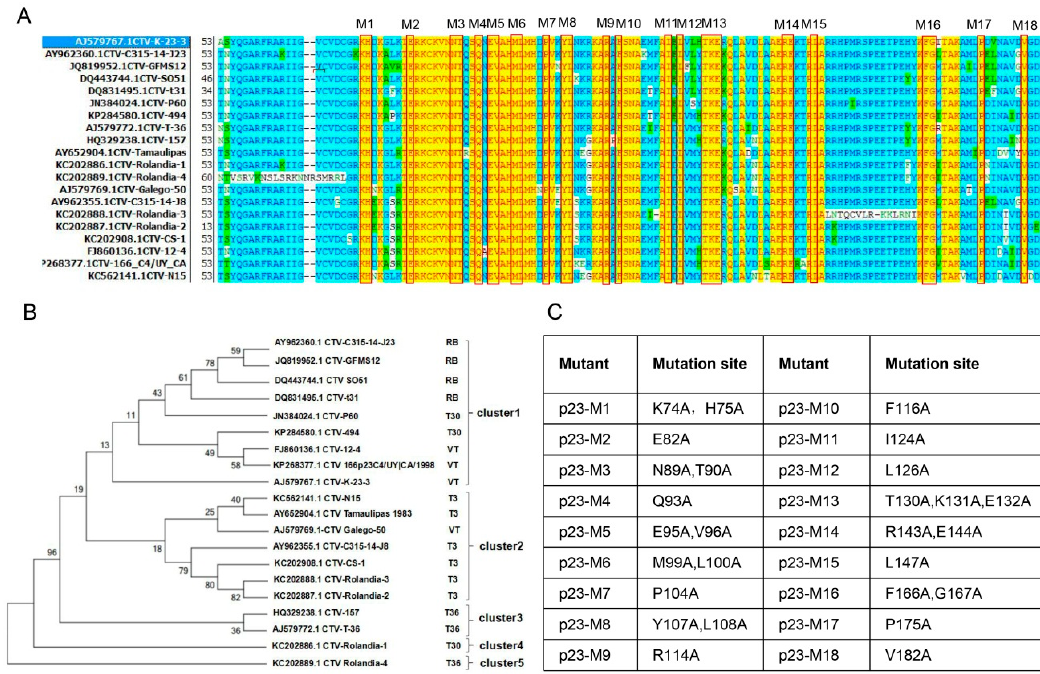
Figure 4. Identification of conserved residues in CTV-p23 for point mutation analysis. ( A ) Alignment of representative p23 sequences from each p23 sequence group. The 20 representative sequences of p23 selected by phylogenetic tree alignment were used for amino acid sequence alignment. Yellow region is conserved sites with identical sequences, selected for mutation and marked in the figure. ( B ) Gene phylogenetic tree analysis of p23 amino acid sequences after grouping. CTV genotypes of p23 sequence for comparison are marked in the figure. ( C ) List of p23 point mutation sites in each